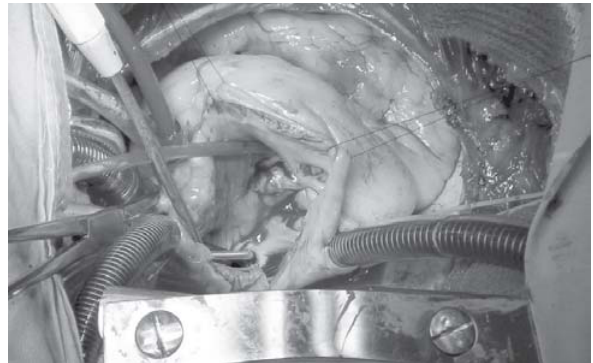
Fig. 1 - Note the location of the pacemaker ventricular lead crossing the interauricular septal